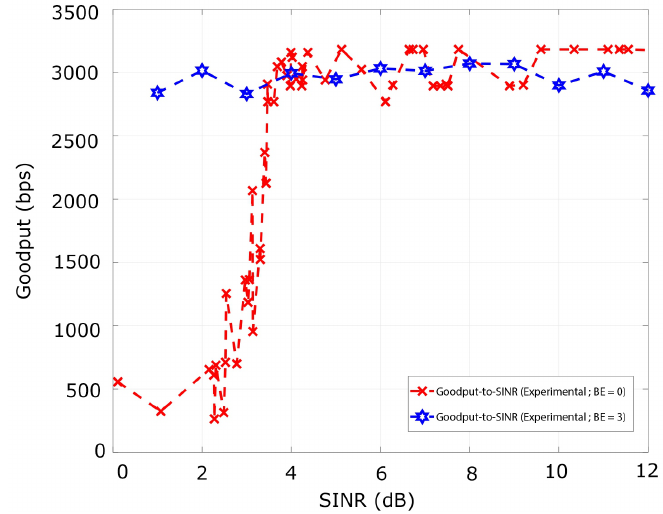
Figure 8. The Goodput-to-SINR curve for BE = 0 and BE = 3 for one transmitter N c = 1 and one interferer N i = 1.